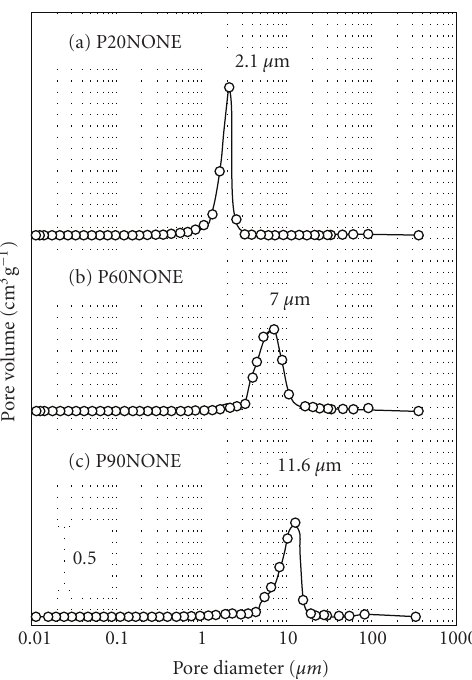
Figure 2: Pore size distributions of (a) P20NONE, (b) P60NONE, and (c) P90NONE.